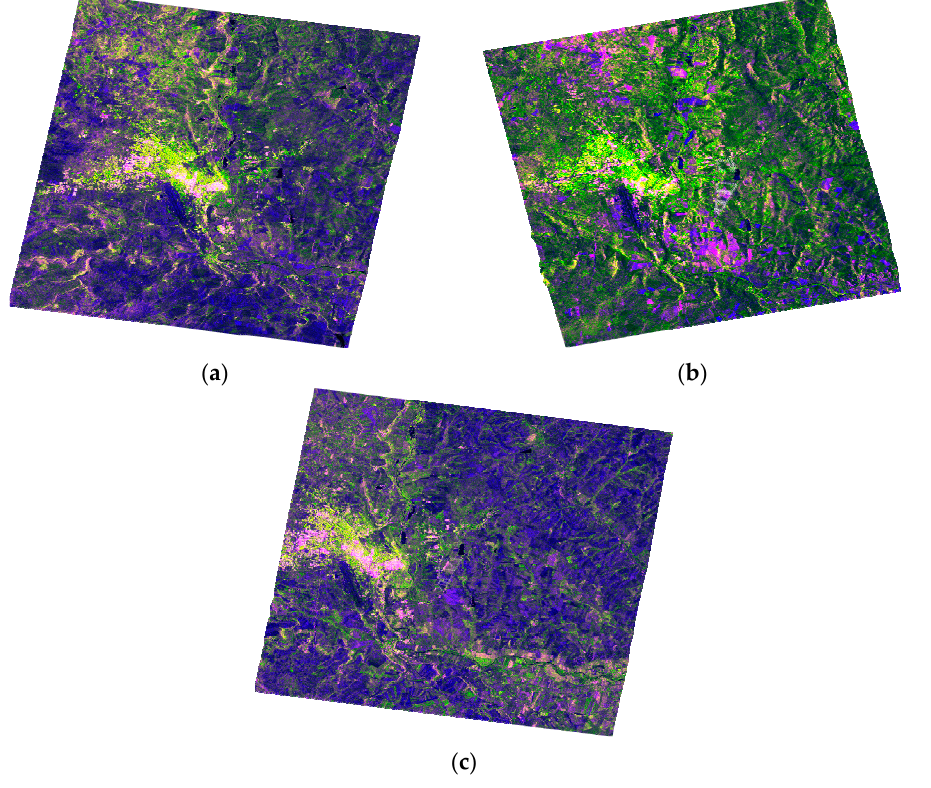
Figure 2. Three Radarsat-2 images were acquired over the Tigris Basin, Diyarbakır and preprocessed on ( a ) 27 February 2015; ( b ) 8 April 2015; and ( c ) 10 June 2015. The Dual pol (hh + vv) RGB image was obtained by combining three different (R = hh; G = vh; B = hh/hv) bands of Radarsat-2 data.